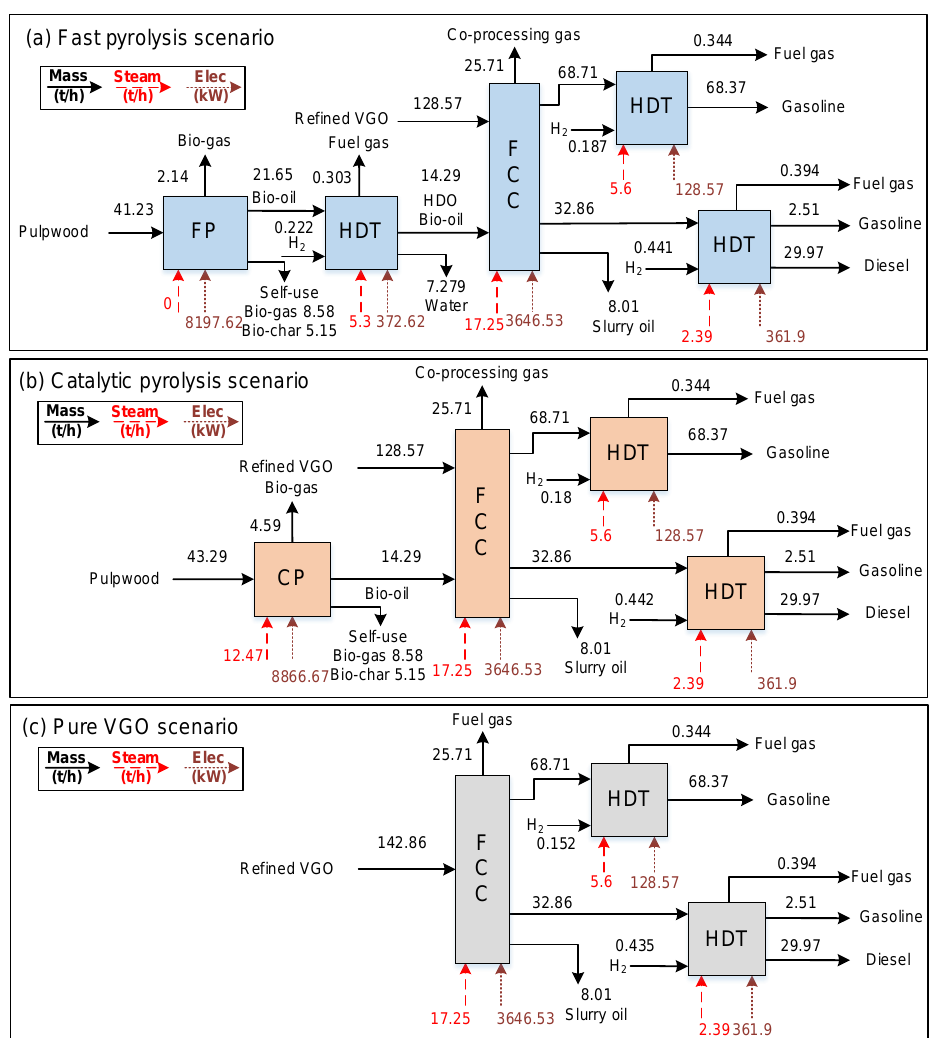
Figure 3. Main mass and energy balances of the three scenarios in Case 1. According to Figure 3, the main differences between the two co-processing scenarios lie in the production process of bio-oil as well as the hydrogen consumption in the existing gasoline and diesel HDT units. In the fast pyrolysis scenario, 41.23 t · h − 1 biomass is pyrolyzed in the reactor and then 14.29 t · h − 1 bio-oil is obtained to be co-processed with the pyrolysis and HDT processes. In the catalytic pyrolysis scenario, 14.29 t · h − 1 bio- oil is produced with the consumption of 43.29 t · h − 1 biomass in the catalytic pyrolysis reactor. In total, 12.47 t · h − 1 steam and 8866.67 kW electricity are consumed in the